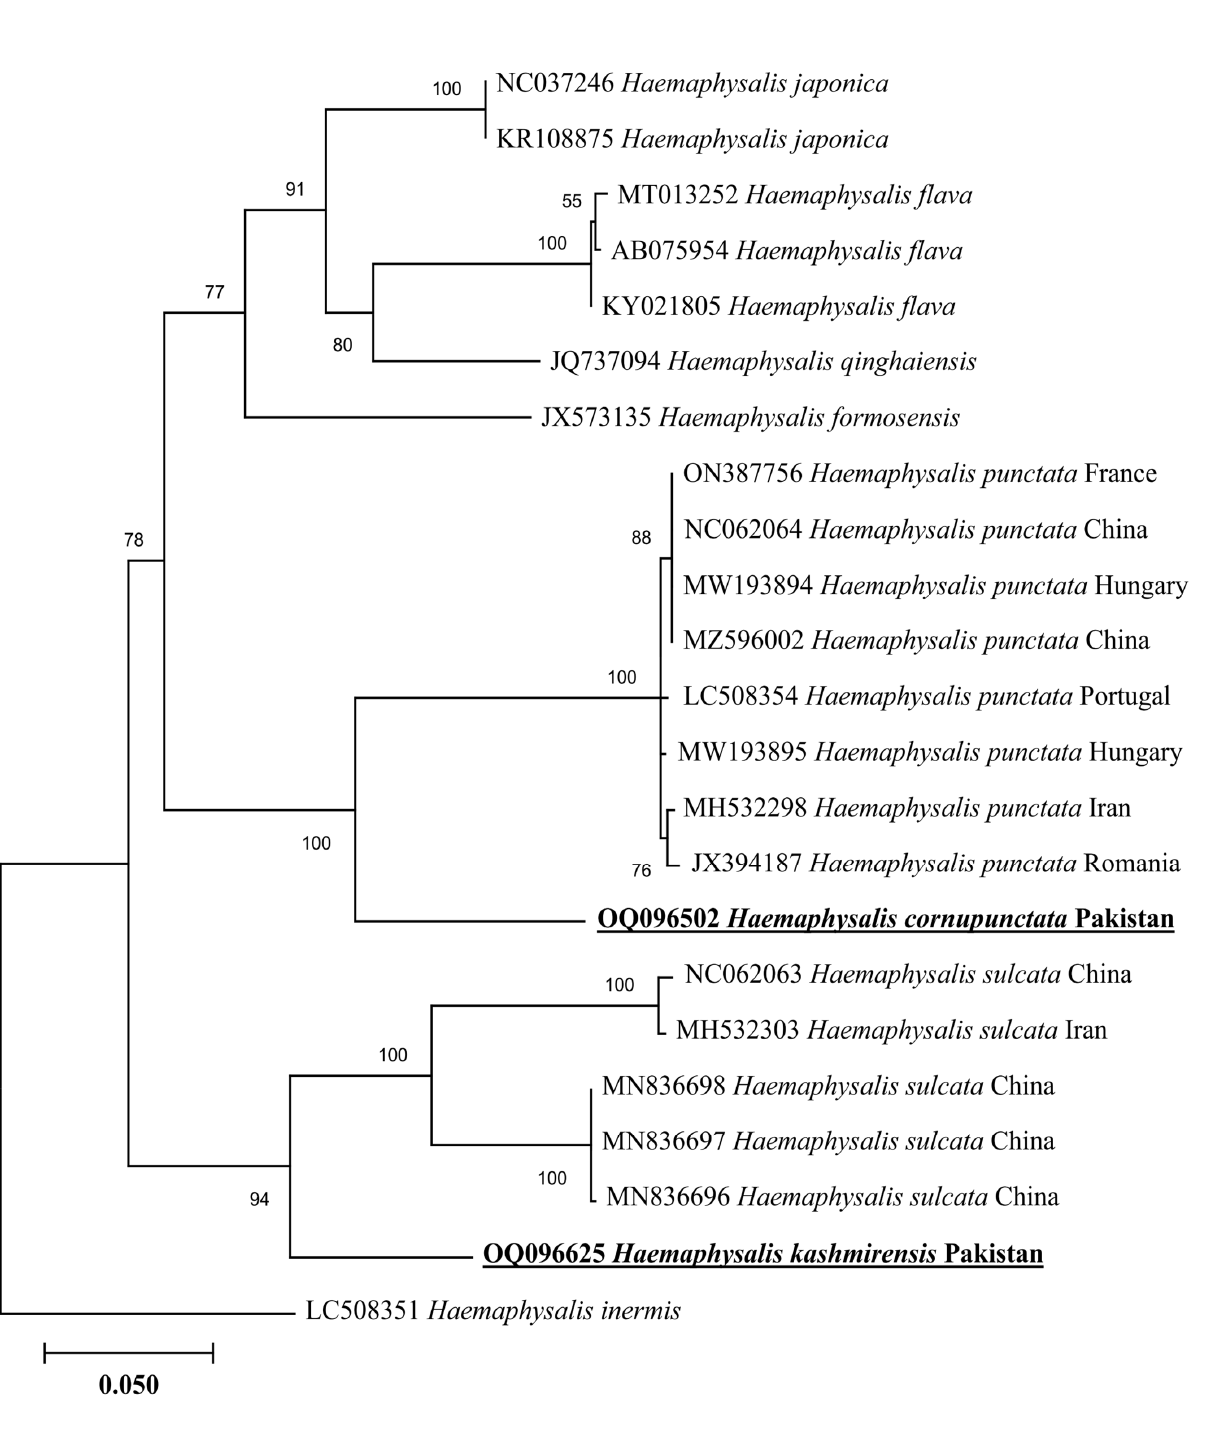
Figure 4. Neighbor-Joining phylogenetic tree based on cox of H. cornupunctata and H. kashmirensis . The cox sequence of H. inermis was employed as an outgroup. All sequences have been denoted by their GenBank accession numbers, followed by species name and country name. The bootstrap values (1000-replications) are shown at each node. The sequences (OQ096502 and OQ096625) of the present study have been marked with bold and underlined fonts.